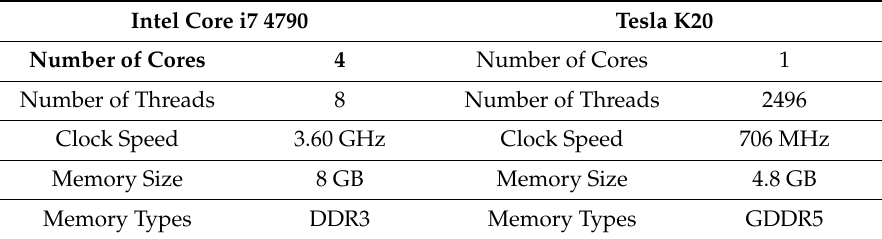
Table 6. Specifications of host and device machines of K20 workstation.